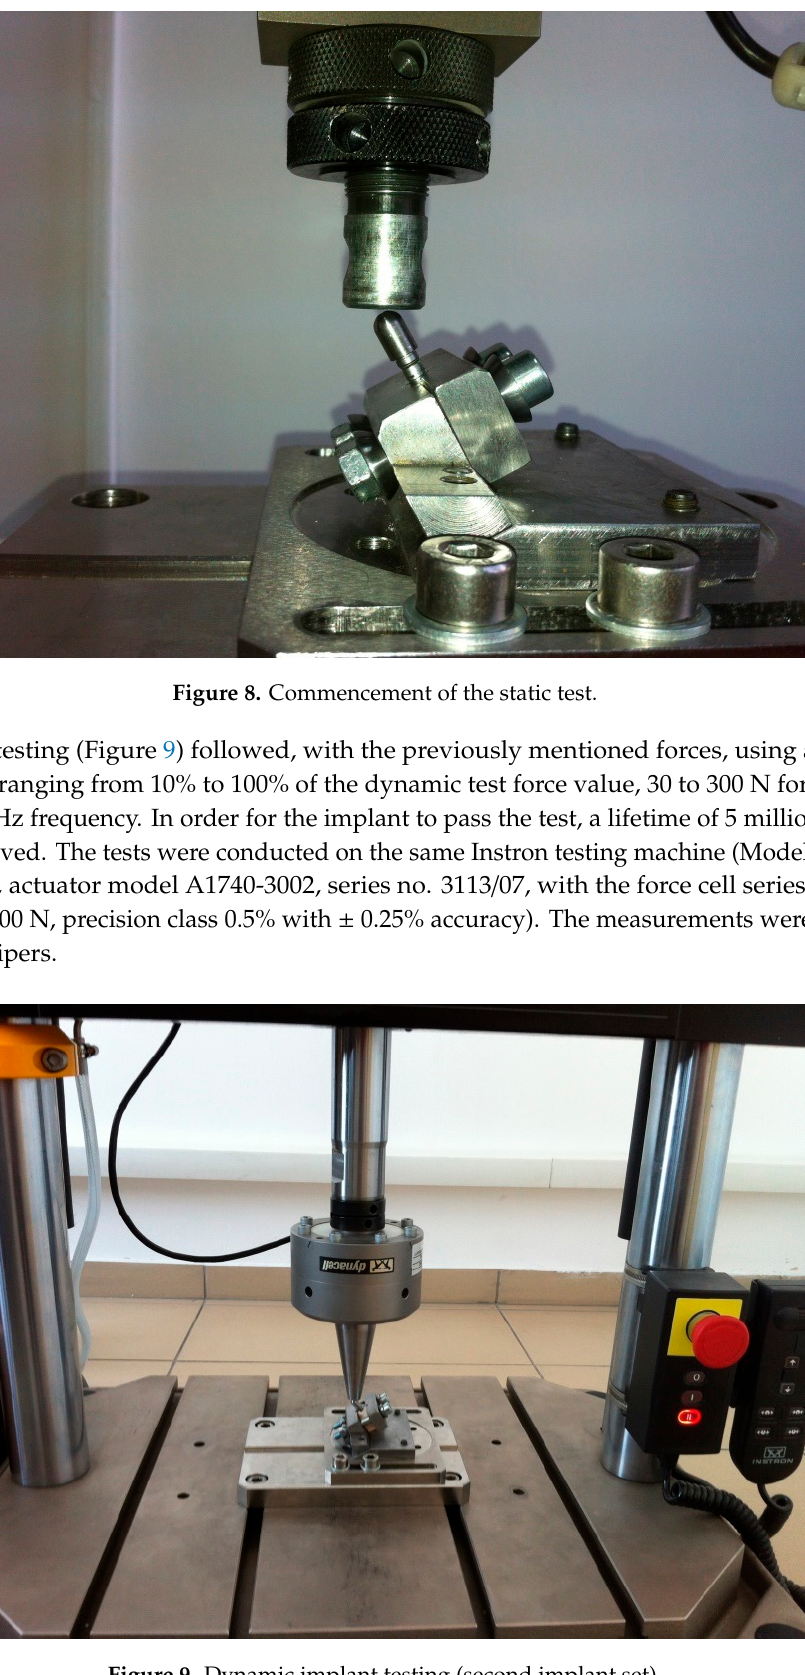
Figure 9. Dynamic implant testing (second implant set).